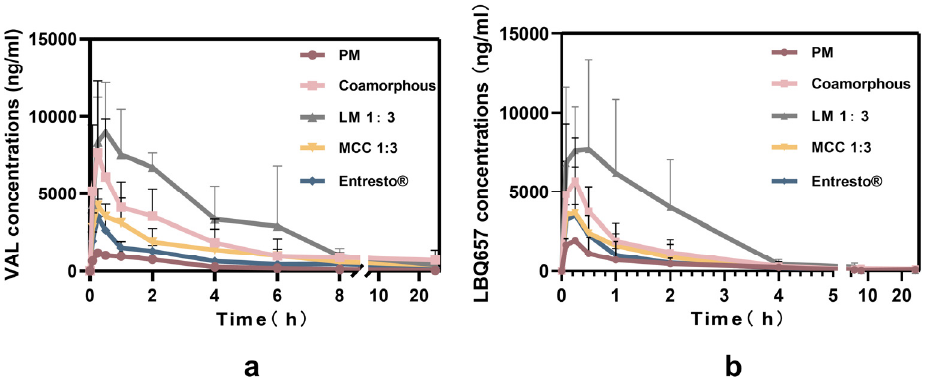
Figure 8. The mean plasma concentrations vs. time profiles of ( a ) VAL and ( b ) LBQ657 after single oral administration to SD rats ( n = 5).